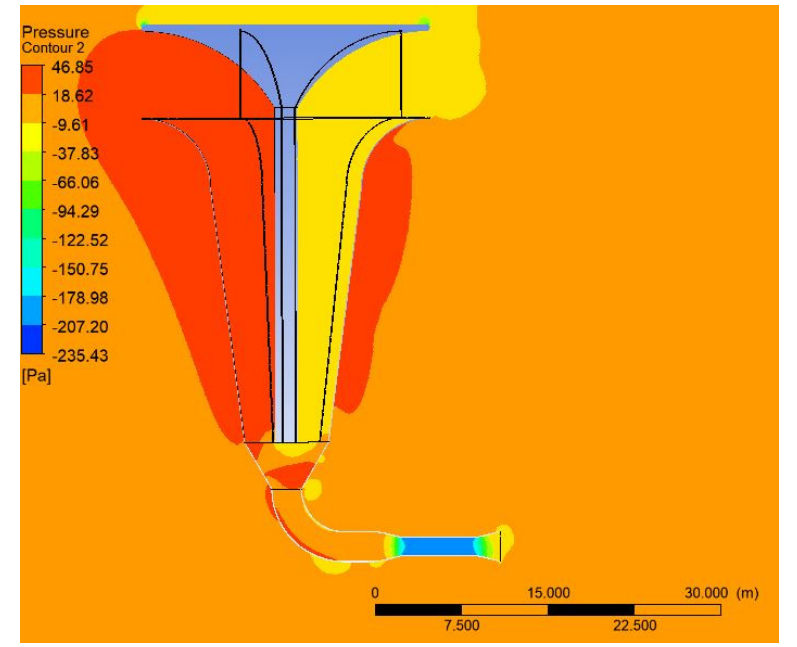
Figure 13. Pressure distribution of the omni-directional wind funnel with free-stream wind speed of 7.4 m/s.